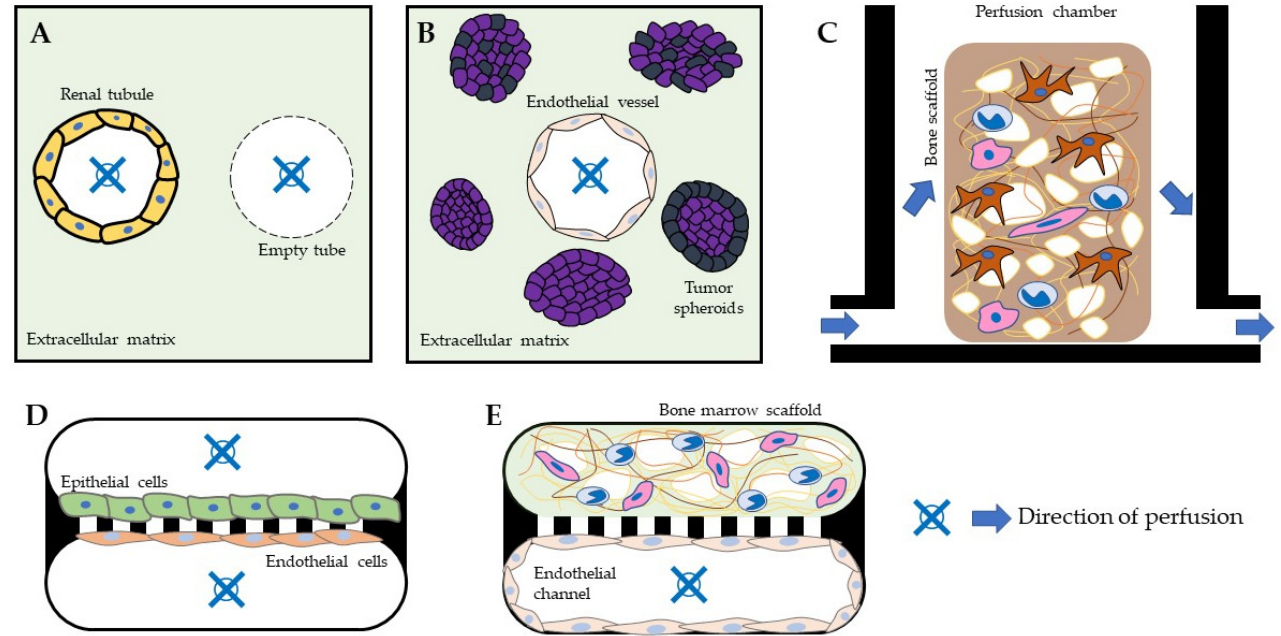
Figure 1. Examples of commercially available microphysiological system designs used in experi- mental urology and orthopaedic research. ( A ) The Nortis ParVivo dual-channel chip design incor- porates two parallel micro-perfusion channels, embedded in an extracellular matrix (ECM). Epithe- lial proximal tubule cells seeded in one channel assemble a tight renal epithelial tubule and are continuously perfused via the lumen. The parallel empty channel is used to load compounds/drugs into the ECM that are exposed to the renal tubule from the outside. This model recreates the apical-basolateral dynamic of the renal proximal tubules with continuous flow through the inside and outside of